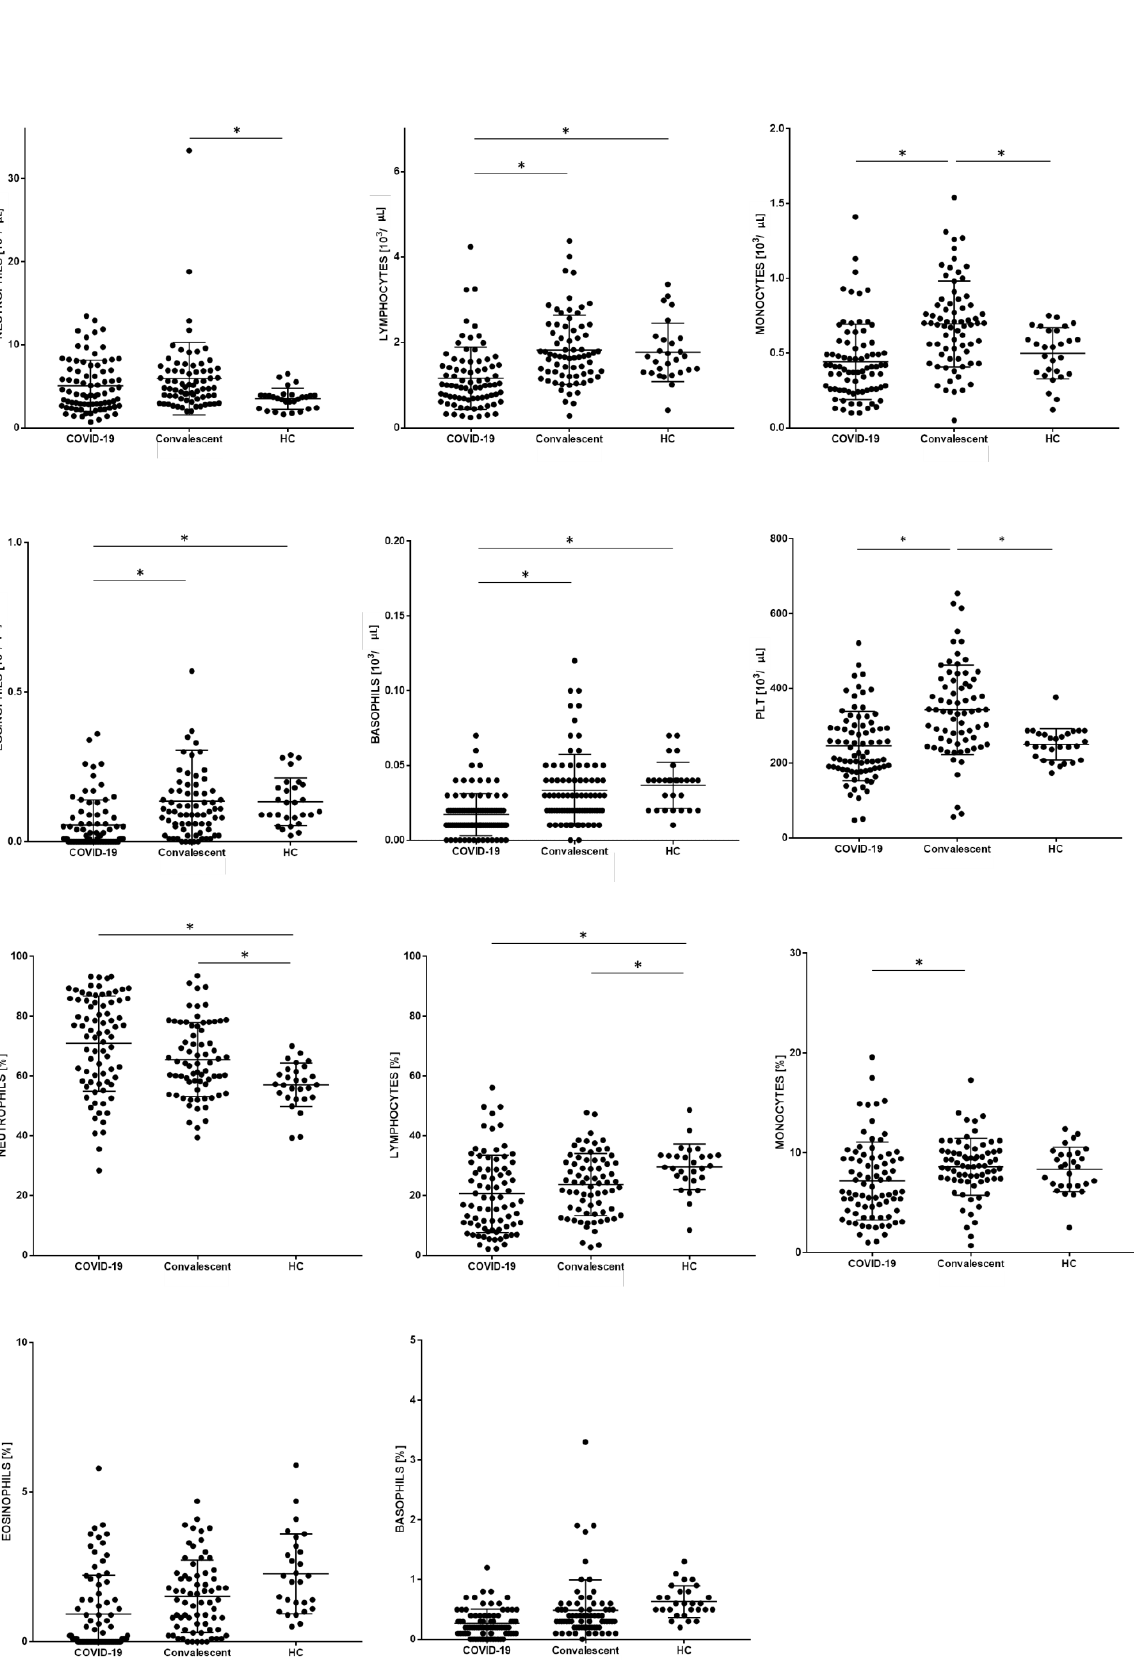
Figure 1. Differences in the proportion of Sysmex morphological parameters between patients with COVID-19, convalescent, and healthy control (HC) groups. Data expressed as median (Min–Max). * indicates p statistically